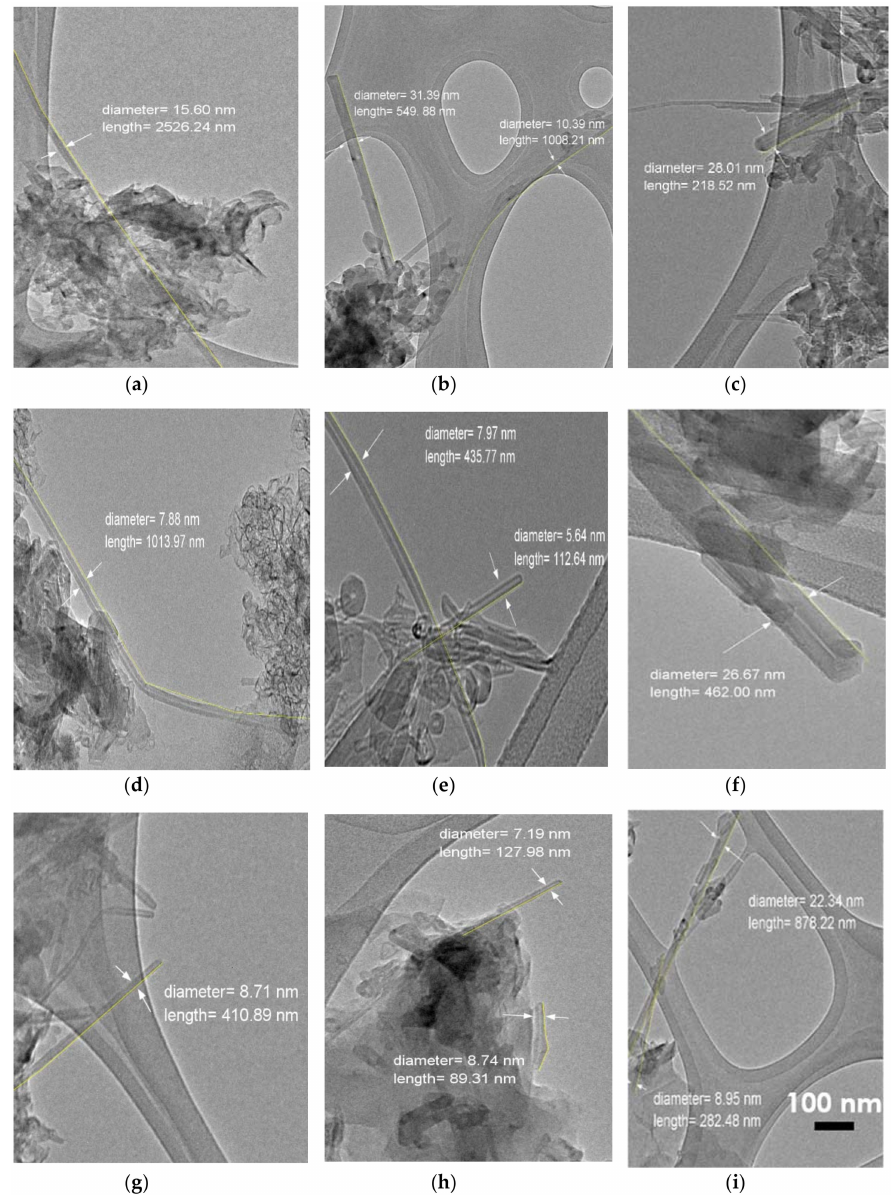
Figure 9. TEM images of the MWCNT growth by the arc discharge plasma with different environments and background pressures: at 10 − 2 , 1, and 10 2 mbar ( a – c ) air; ( d – f ) Ar; and ( g – i ) H 2 (all images are in same scale